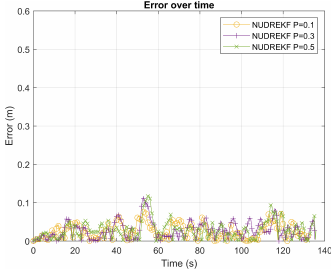
Figure 15. Comparison results for a Lissajous reference.